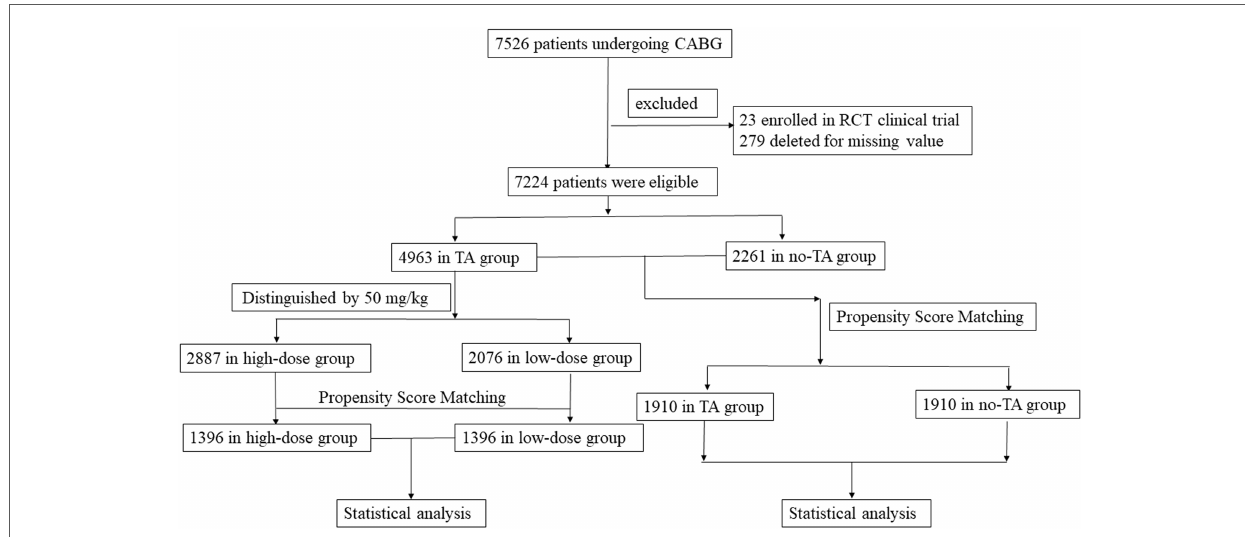
FIGURE 1 Flowchart of elderly patients undergoing CABG surgery with or without TA administration. This study included 7,526 patients older than 70 years treated by CABG surgery. Patients enrolled in RCT studies or with missing values were removed from this study. Finally, a total of 7,224 elderly patients were selected for this study. Among them, the TA group had 4,963 patients, and the no-TA group had 2,261 patients. In the TA group, 2,887 patients were administered a TA dose ≥ 50 mg/kg, and the remaining 2,076 patients were administered a TA dose <50 mg/kg. The outcomes between the TA and no-TA groups or the high-dose and low-dose groups were compared by PSM and subsequent statistical analysis. CABG, coronary artery bypass grafts; RCT, random control trial; TA, tranexamic acid; PSM, propensity score